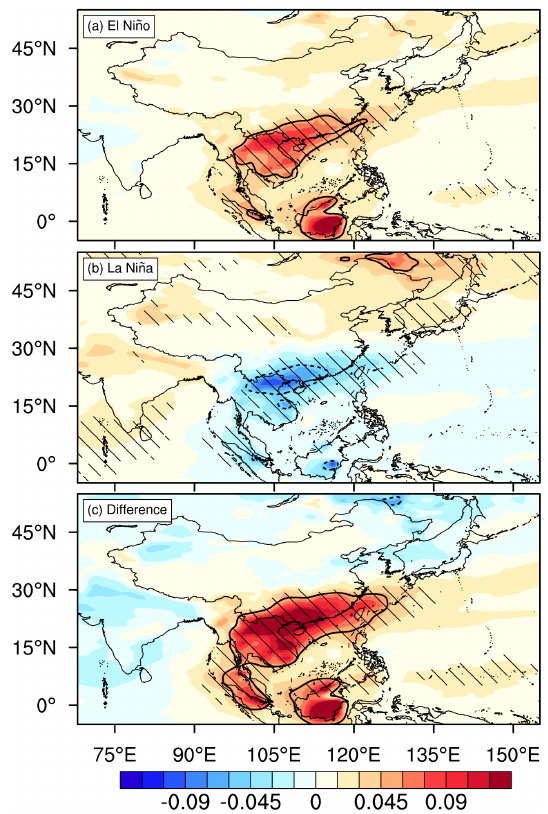
Figure 4. Composite anomalies of spring AOD (shading) during (a) El Niño and (b) La Niña and (c) their differences (El Niño minus La Niña). Solid black (dashed) contours outline the areas where the AOD anomalies are larger (smaller) than 0.05 ( − 0.05). Hatching denotes the anomalies statistically significant at the 95% confidence level based on the Student’s t test.